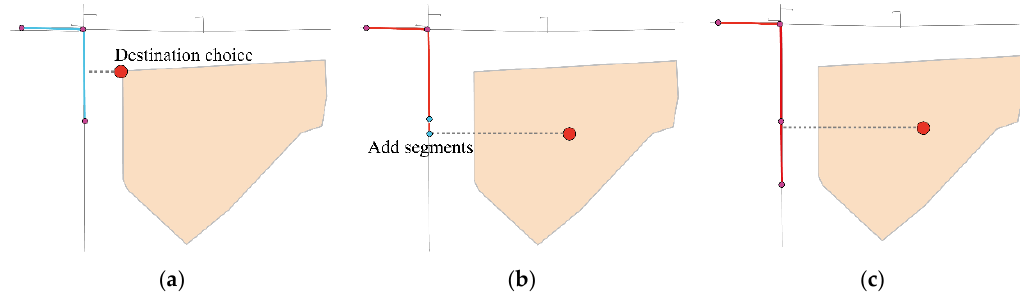
Figure 5. shortest path findings with ( a ) existing road segment to the closest shape point; ( b ) add a segment to the centre point; ( c ) existing road segment to the centre point. segment to the centre point; ( c ) existing road segment to the centre